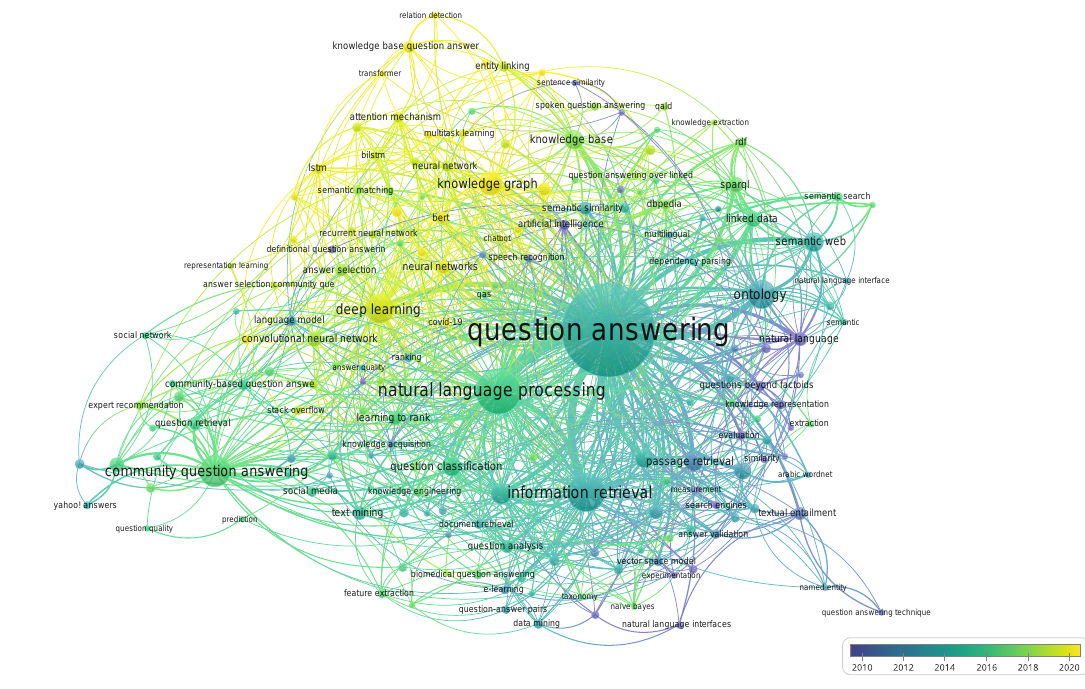
Figure 15. Co-occurrence Overlay Visualization. Co-occurrence analysis is performed on author keywords using VOSViewer. Key- words occurring with more than five are only considered for the analysis. 178 keywords out of 3697 met the criteria. Top-15 keywords are listed in Table 13 for the question- answering